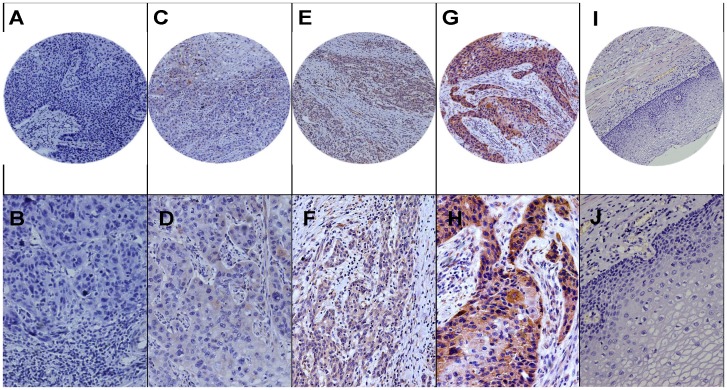
PIK3CA expression in ESCC.Representative immunohistochemistry images of PIK3CA expression across multiple tumor grades. PIK3CA protein was localized on the cytoplasm of tumor cells. Tumors were scored on a scale from grade 0 to 3+. (A) grade 0, 100×; (B) grade 0, 200×; (C) grade 1+, 100×; (D) grade 1+, 200×; (E) grade 2+, 100×; (F) grade 2+, 200×; (G) grade 3+, 100×; (H) grade 3+, 200×; (I) normal mucosa, 100×; and (J) normal mucosa, 200×.